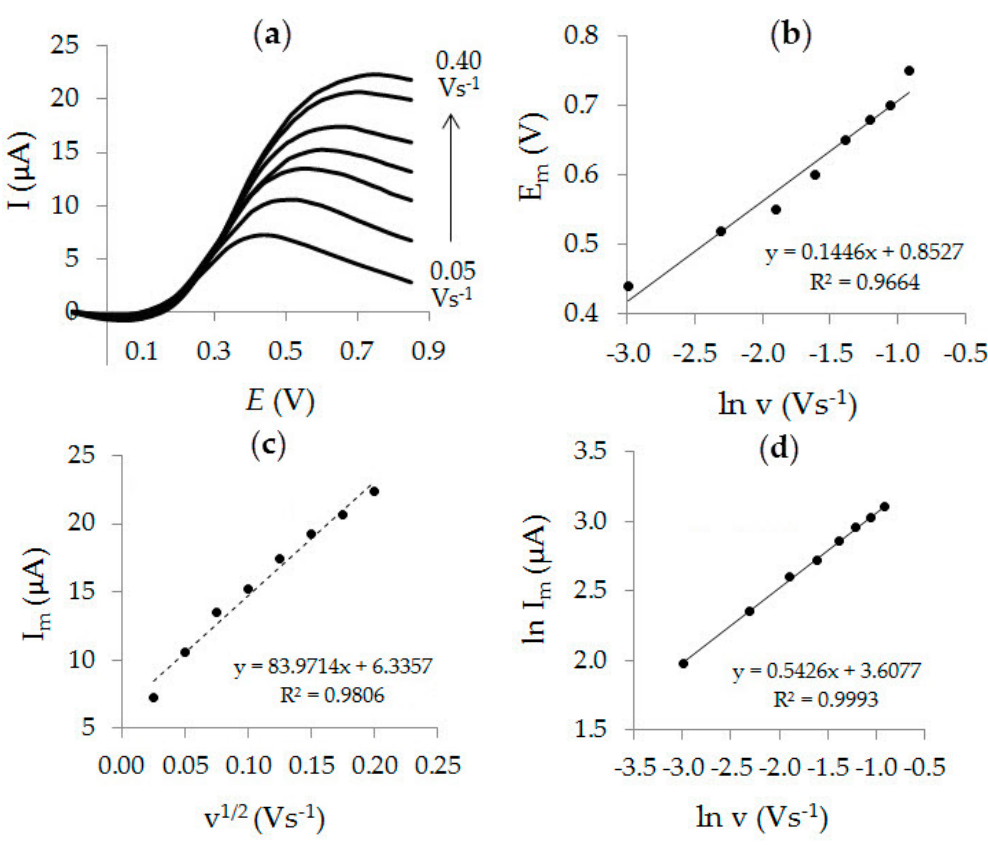
Figure 7. LS voltammograms of 0.1 mM AA on Au-gr/CVE in PBS pH 6 at different potential scan rates (0.05–0.40 Vs − 1 ), ( a ) and dependences E m = f (ln ν ) ( b ), I m = f ( ν 1/2 ) ( c ), ln I m = f (ln ν ) ( d ).